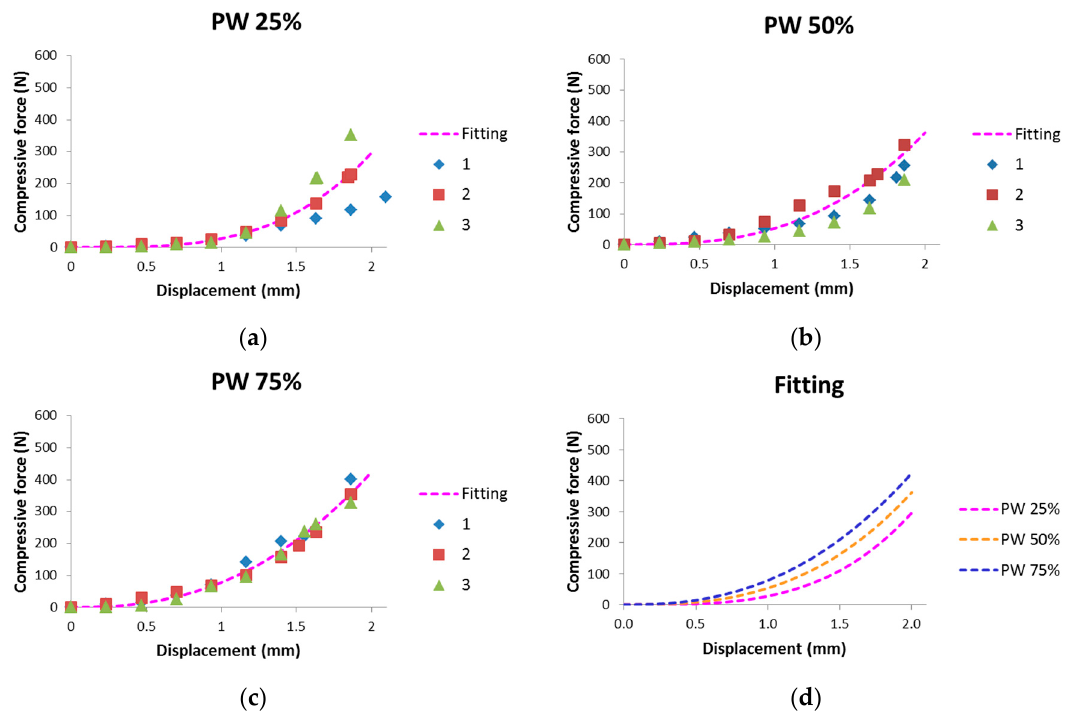
Figure 9. Compressive force with respect to displacement in the in-mold stiffness measurement of the multi-layered fiber preforms with various ratios of PW to UD carbon fabric: ( a ) PW 25%; ( b ) PW 50%; and ( c ) PW 75%; and ( d ) force by in-mold stiffness of the multi-layered preforms with respect to displacement.